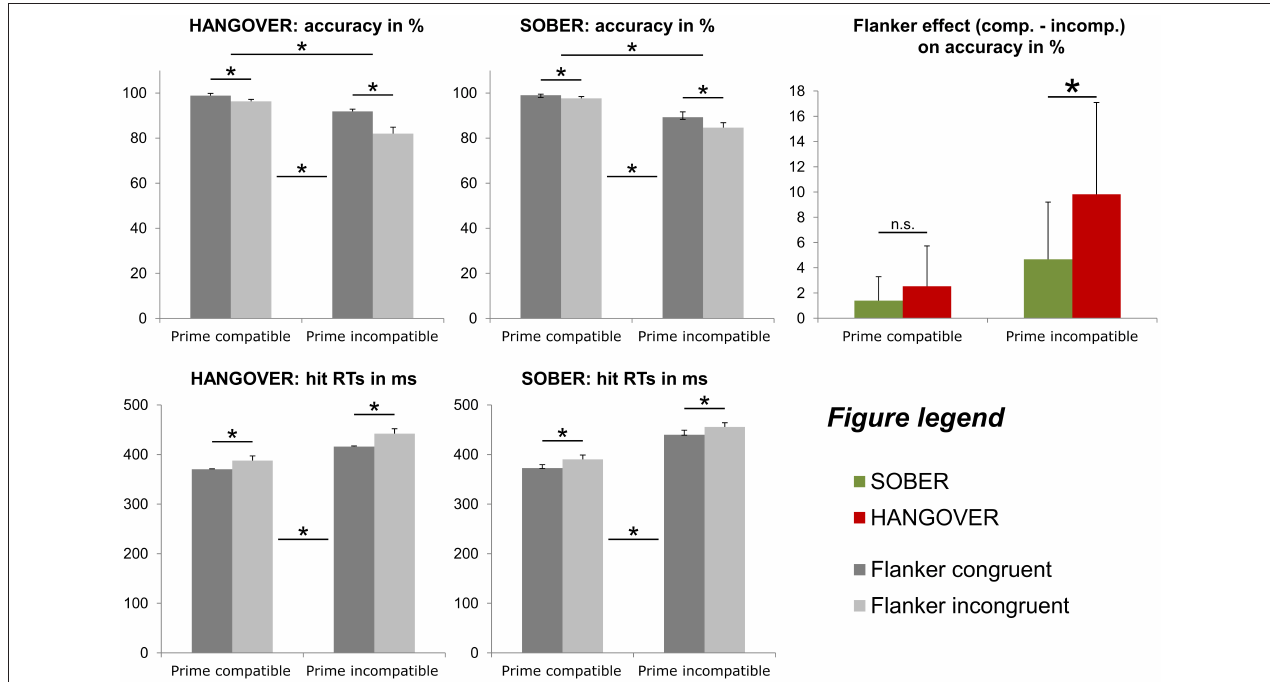
FIGURE 5 | Illustration of the behavioral results obtained with the conflict paradigm adapted from Boy et al. (2010). In line with the findings of previous publications on this paradigm, both types of distractors (subliminal primes and consciously processed flankers) induced a significant conflict, as indicated by decreased accuracy (top row) and increased response times (bottom row). Furthermore, subliminal conflict load (i.e., incompatible primes) increased the flanker effect on accuracy (top row). With respect to hangover effects, we found that hungover participants displayed a significantly larger flanker effect, but only when the subliminal prime was incompatible (see colored graph on the right). Error bars denote the standard error of the mean (SEM). Asterisks denote significant effects (for practical reasons, hangover effects are only denoted in the very right graph).